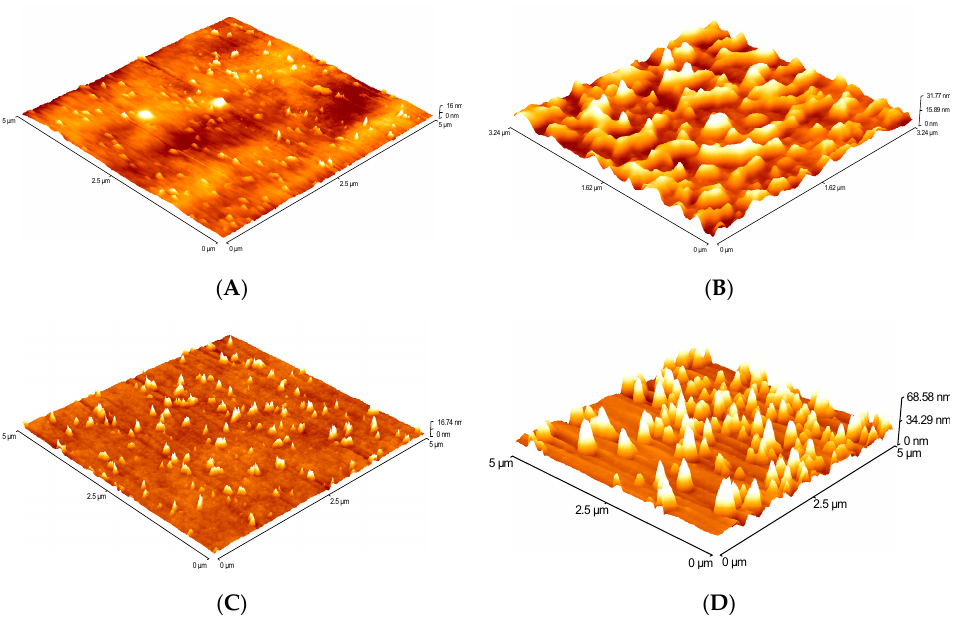
Figure 11. AFM images: ( A ) blend 3 nonplasma treatment, ( B ) blend 3 plasma treatment, ( C ) blend 8 nonplasma treatment, and ( D ) blend 8 plasma treatment.